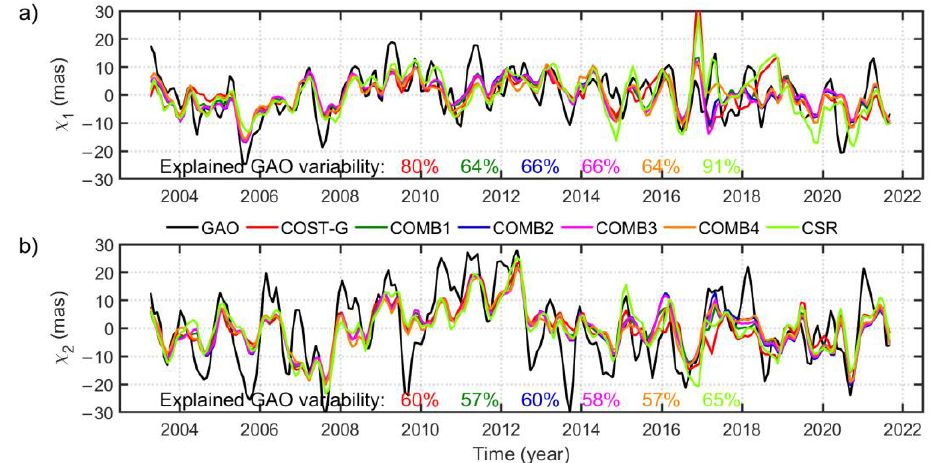
Figure 3. Time series of χ 1 ( a ) and χ 2 ( b ) components of GAO and gravimetric excitation determined from a single GRACE/GRACE-FO solution (CSR), combined GRACE/GRACE-FO solution (COST-G), and the four combined solutions developed in this study (COMB1, COMB2, COMB3, and COMB4). The plots include values of explained GAO variability, which was computed as a relation between STD of gravimetric excitation and STD of GAO (STD gravimetric excitation /STD GAO ) given in %. In order to check the power of particular oscillations in the excitation series, we drew the amplitude spectra of complex- valued components of χ 1 + iχ 2 and consider their pro- grade (counter-clockwise) and retrograde (clockwise) parts (Figure 4). The spectra show